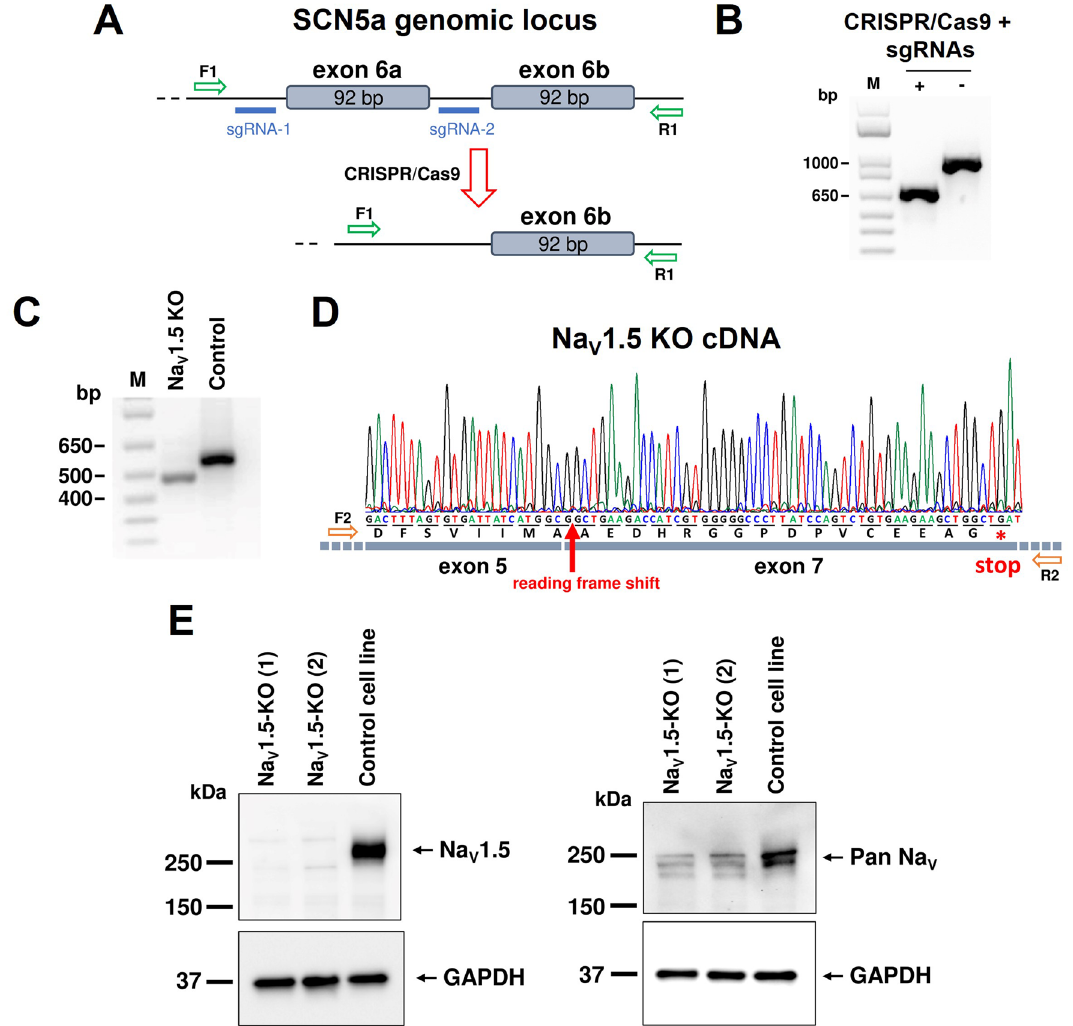
Figure 1. CRISPR-Cas9 genome editing to target SCN5a . ( A ) A schematic representation of the SCN5a locus and the sgRNA target sites located upstream and downstream from exon 6a. The sgRNA pair (blue) were designed to excise exon 6a in the SCN5a locus following CRISPR-Cas9 editing. The PCR primers used to screen and verify the nucleofected iPSC clones are shown in green. ( B ) PCR analysis of the positive iPSC clone used in this study amplified with primers shown in ( A ). Positive clone carrying a 685-bp PCR amplicon and non-nucleofected iPSC carrying a 962-bp amplicon. ( C ) PCR analysis on Na V 1.5 cDNA using RNA extracted form iPSC-CM. The primers targeted the regions corresponding to exon 5 and exon 7 of Na V 1.5 cDNA. PCR amplicons with a 92-bp deletion (Na V 1.5 KO) or no deletion (control iPSC) corresponding to exon 6 are shown. ( D ) Sequencing chromatogram of the deleted PCR product in ( C ) from the Na V 1.5 KO cell line showing the 92 bp deletion of exon 6 and the creation of stop codon induced by the frame shift of the reading frame. ( E ) Western blot analysis of Na V 1.5 KO and control iPSC-CM. Anti-Na V 1.5 (left panel) and the Anti-Pan Na V antibodies (right panel) were used to assess the expression of Na + channels. GAPDH staining was used as a loading control. Na V 1.5 KO (1) and Na V 1.5 KO (2) come from the same cell line but from two independent cardiac differentiation. This figure was made using MICROSOFT POWERPOINT Version 2106 (build 14131.20278 Office, https:// docs. micro soft. com/ en- us/) and IMAGEJ 1.52i (Java 1.8.0_66, http:// imagej. nih. gov/ the other was used to maintain and expand the positive clones. The PCR screening used the F1, 5 ′ -GAC CAG AAA TGC ACT TGC TTC CTG TA and R1, 5 ′ -GGT GTC TAT GAG AGT GGG CTT TGC T primers, which target regions surrounding the cutting sites of the sgRNAs. Positive clones, those with exon 6a removed, are characterized by a 682-bp PCR amplicon while negative clones are characterized by a 962-bp amplicon (Fig. 1B). One positive clone was chosen for the present study and was named Na V 1.5 KO. cDNA analysis. RNA was extracted from Na V 1.5 KO iPSC-CMs and the control cell line on day 30 of matu- ration using Quick RNA mini-prep kits (Zymo Research, CA, USA). cDNA was synthesized using the Proto-